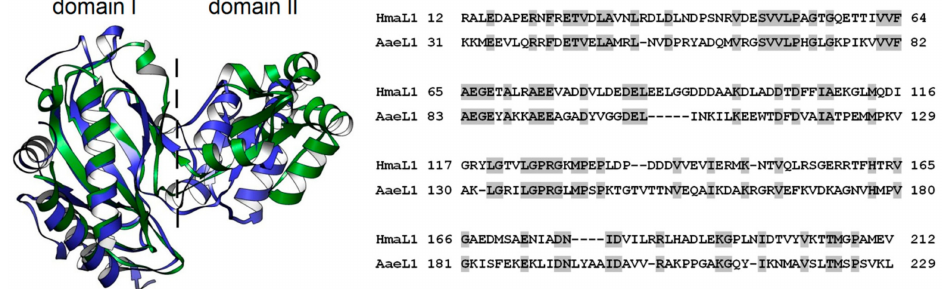
Figure 5. ( Left ) Superposition of three-dimensional structure of AaeL1 (PDB:3QOY) (blue) and modelled of three-dimensional structure of HmaL1 [44] (green). The dashed line separates two domains, I and II. ( Right ) Alignment of ribosome proteins HmaL1 and AaeL1. The identical residues are highlighted in gray. Alignment of amino acid sequences of the proteins in BLAST (https: // blast.ncbi.nlm.nih.gov / Blast. cgi) showed 33% amino acid identity between AaeL1 and HmaL1. Figure 5 (right) shows alignment of amino acid sequences of two proteins, the identical amino acid residues are colored gray. AaeL1 and HmaL1 di ff er in their length: AaeL1 consists of 242 a.a., HmaL1 consists of 212 a.a.